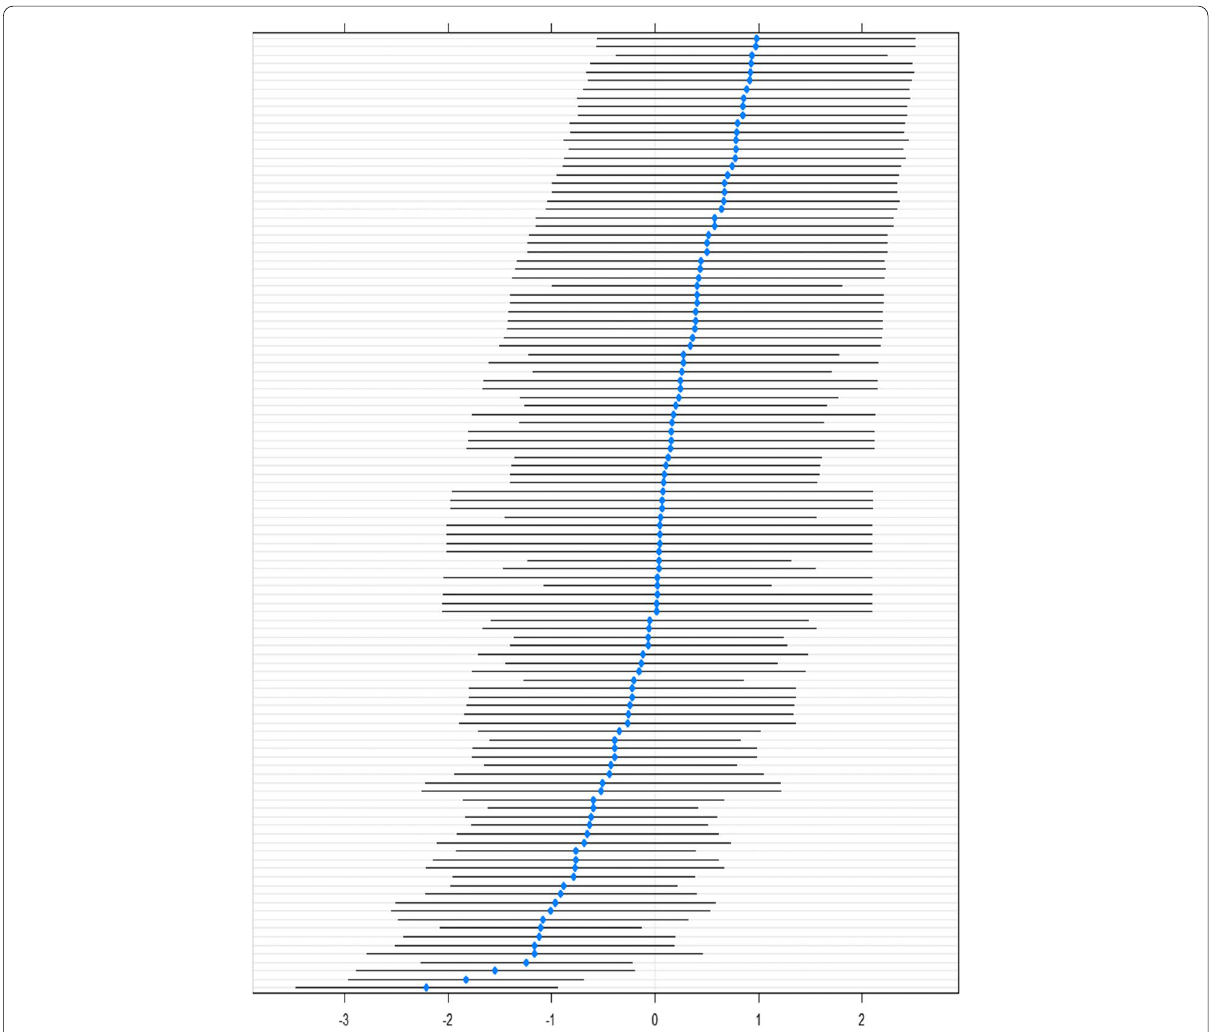
Fig. 3 Variation in the in vitro survival of the proliferating ash clones from best to worst, after rooting induction. The blue dots represent the best linear unbiased predictors (BLUPs) for in vitro survival of individual clones and the black bars show the 95% confidence interval for the BLUP. The reference numbers for the individual clones have been removed for reasons of clarity, but are available with the supplementary documents submitted to the Zenodo data repository